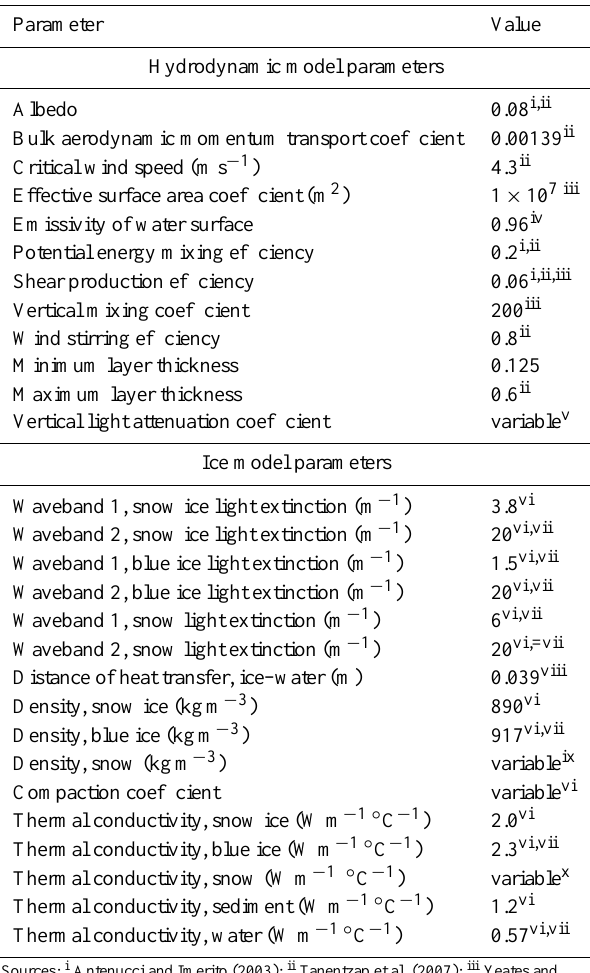
Table 1. Values of DYRESM-ICE parameters and model simulation specifications for both hydrodynamic and ice cover portions of the